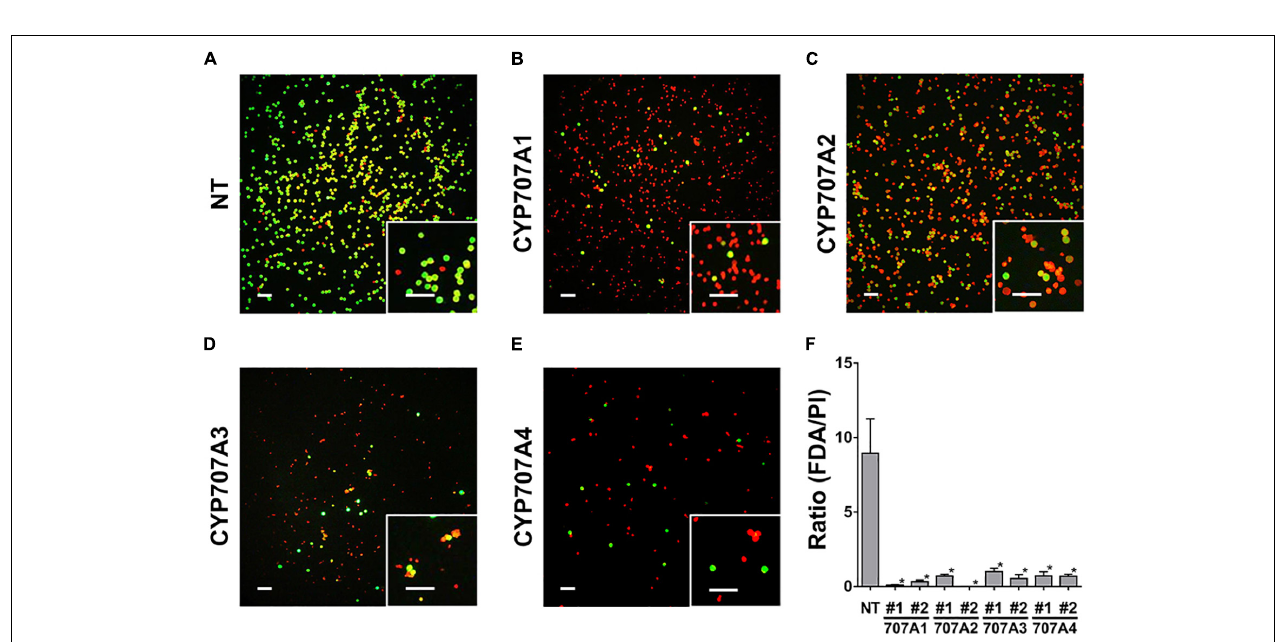
FIGURE 8 | Suppressed pollen viability in 35S:CaCYP707A plants. Pollen viability was visualized by FDA and PI staining. Pollen collected from the flowers (anthesis stage) of NT and 35S:CaCYP707A transgenic plants were stained with a mixture of FDA and PI for 5 min, and then fluorescent signals were observed by fluorescence microscopy [ (A) , NT; (B) , CaCYP707A1 #1; (C) , CaCYP707A2 #1; (D) , CaCYP707A3 #1; and (E) , CaCYP707A4 #1]. More than three individuals of the indicated plants were analyzed with similar results. (F) Quantification of the ratio of FDA (green) to PI (red) signals in the indicated plants ( n > 3). The values are the means of three biological replicates, and error bars are S.D. #1 and #2 indicate individual lines of the indicated transgenic plants. Asterisks indicate significant differences between the transgenic plants and NT controls (Student t -test p < 0.01). Scale bars = 100 µ m. The experiments were performed at least three times with similar